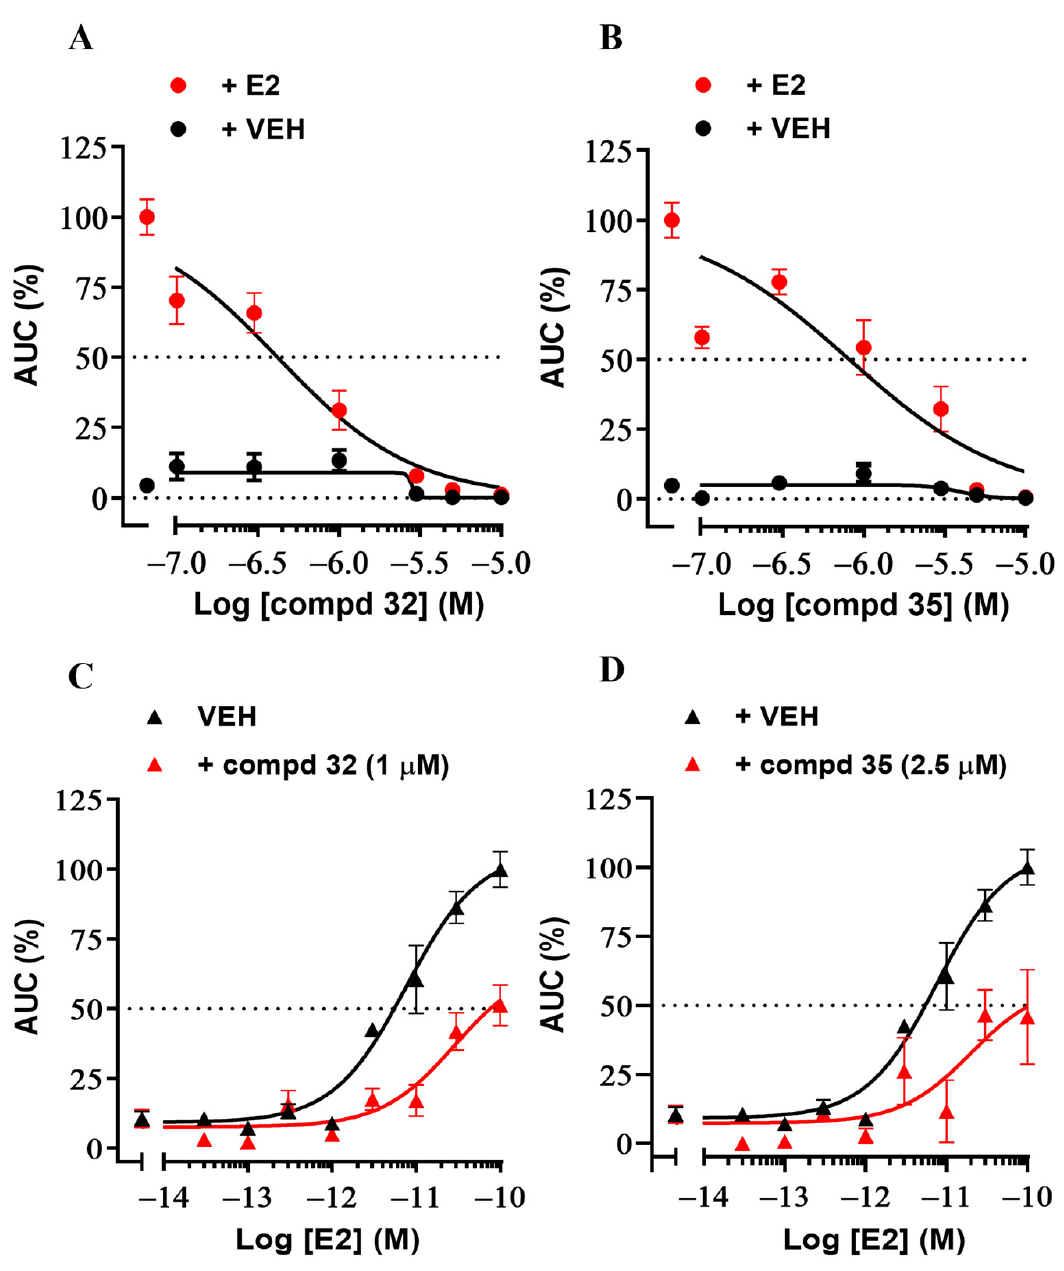
Figure 8. 5-Hydroxy-2 H -pyrrol-2-ones 32 and 35 exhibit antiestrogenic effects on E2-induced growth of ER+ breast cancer cells. ( A , B ) E2-depleted T47D cells were treated with vehicle (VEH, 0.05% DMSO), compound ( A ) 32 or ( B ) 35 (both, 0.01–10 µM) in the absence (VEH, ● ) or presence of E2 (0.1 nM, ● ) for 10 days. Cell growth kinetics were calculated by the area under the curve (AUC) for compounds alone (+VEH) or compounds+E2. Dotted lines are shown at 0 % and 50 % of AUC. Non-linear regression analysis was applied with GraphPad Prism software 8.4.3 to calculate EC 50 or IC 50 values. Data are expressed as mean ± SEM for at least three independent experiments, where each treatment was tested in triplicate. ( C , D ) Cells were treated with dose-response curves of E2 (0.03 pM–100 pM) alone (+ VEH, 0.05% DMSO, ▲ ) or in the presence of a constant concentration of compound ( C ) 32 (1 µM, ▲ ) or ( D ) 35 (2.5 µM, ▲ ) for 10 days. Cell growth kinetics were calculated by the AUC for E2+VEH or E2+compounds. Then non-linear regression analysis was applied to calculate their respective EC 50 values.